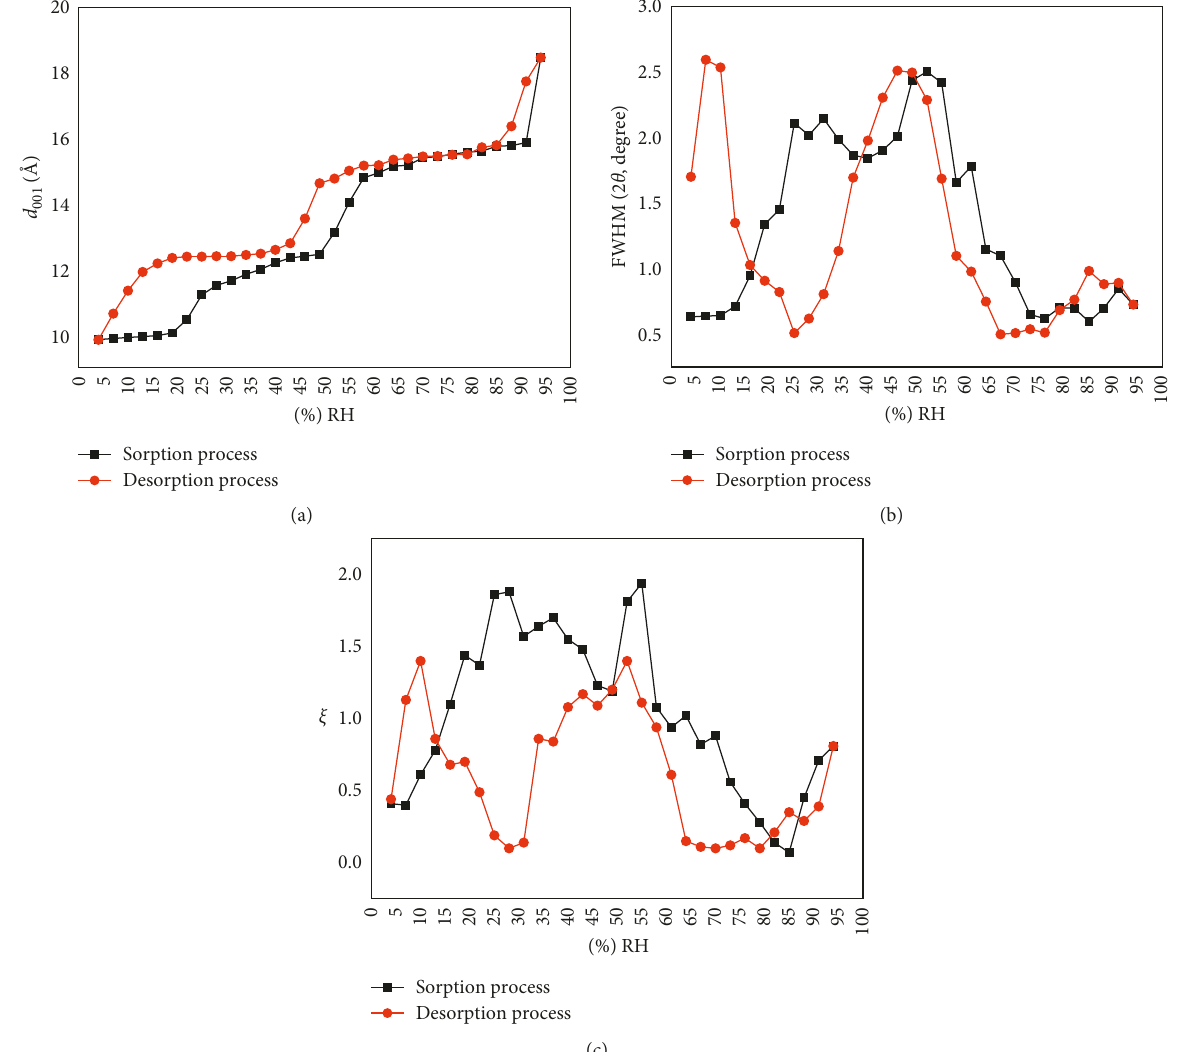
Figure 5: Evolution of the d 001 (a), FWHM (b), and ξ parameters (c) versus %RH in the case of the stressed